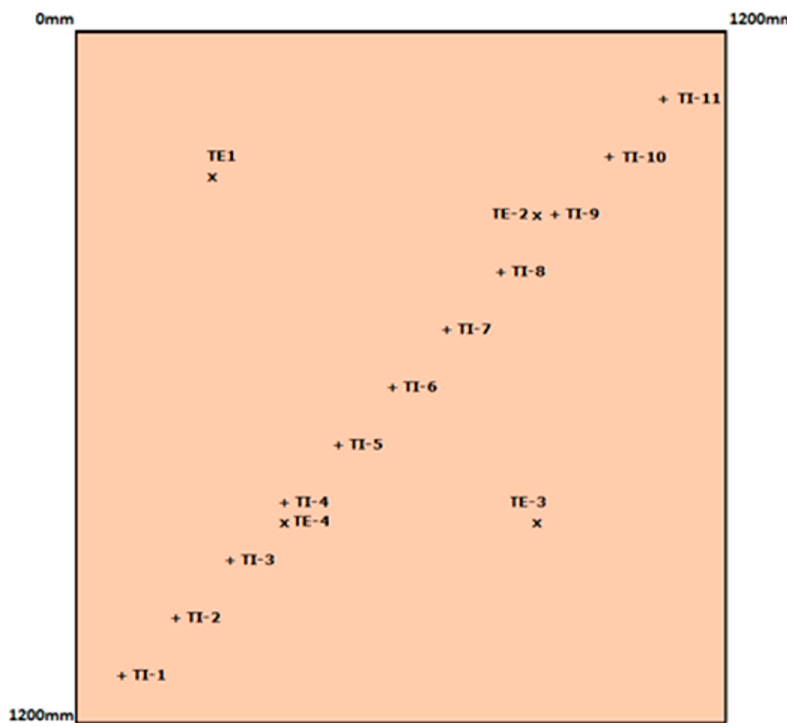
Figure 3. Location of external (TE) and internal (TI) thermocouples.